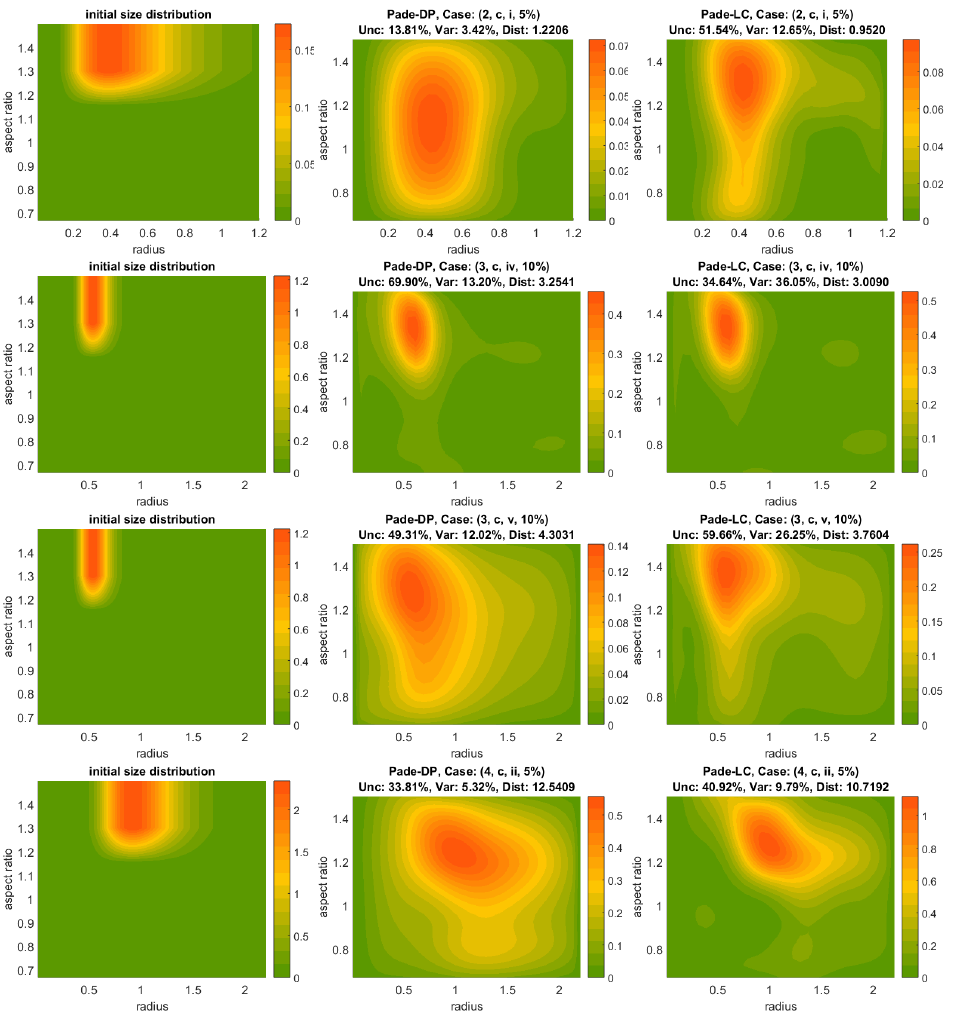
Figure 5. Shape-size distribution reconstructions produced by Padé-DP, Padé-LC for several cases. From left to right: initial shape-size distribution, Padé-DP-reconstructed distribution, Padé-LC- reconstructed distribution. The triple (Unc, Dist, Var) in the title of each plot refers to error-related quantities of shape-size